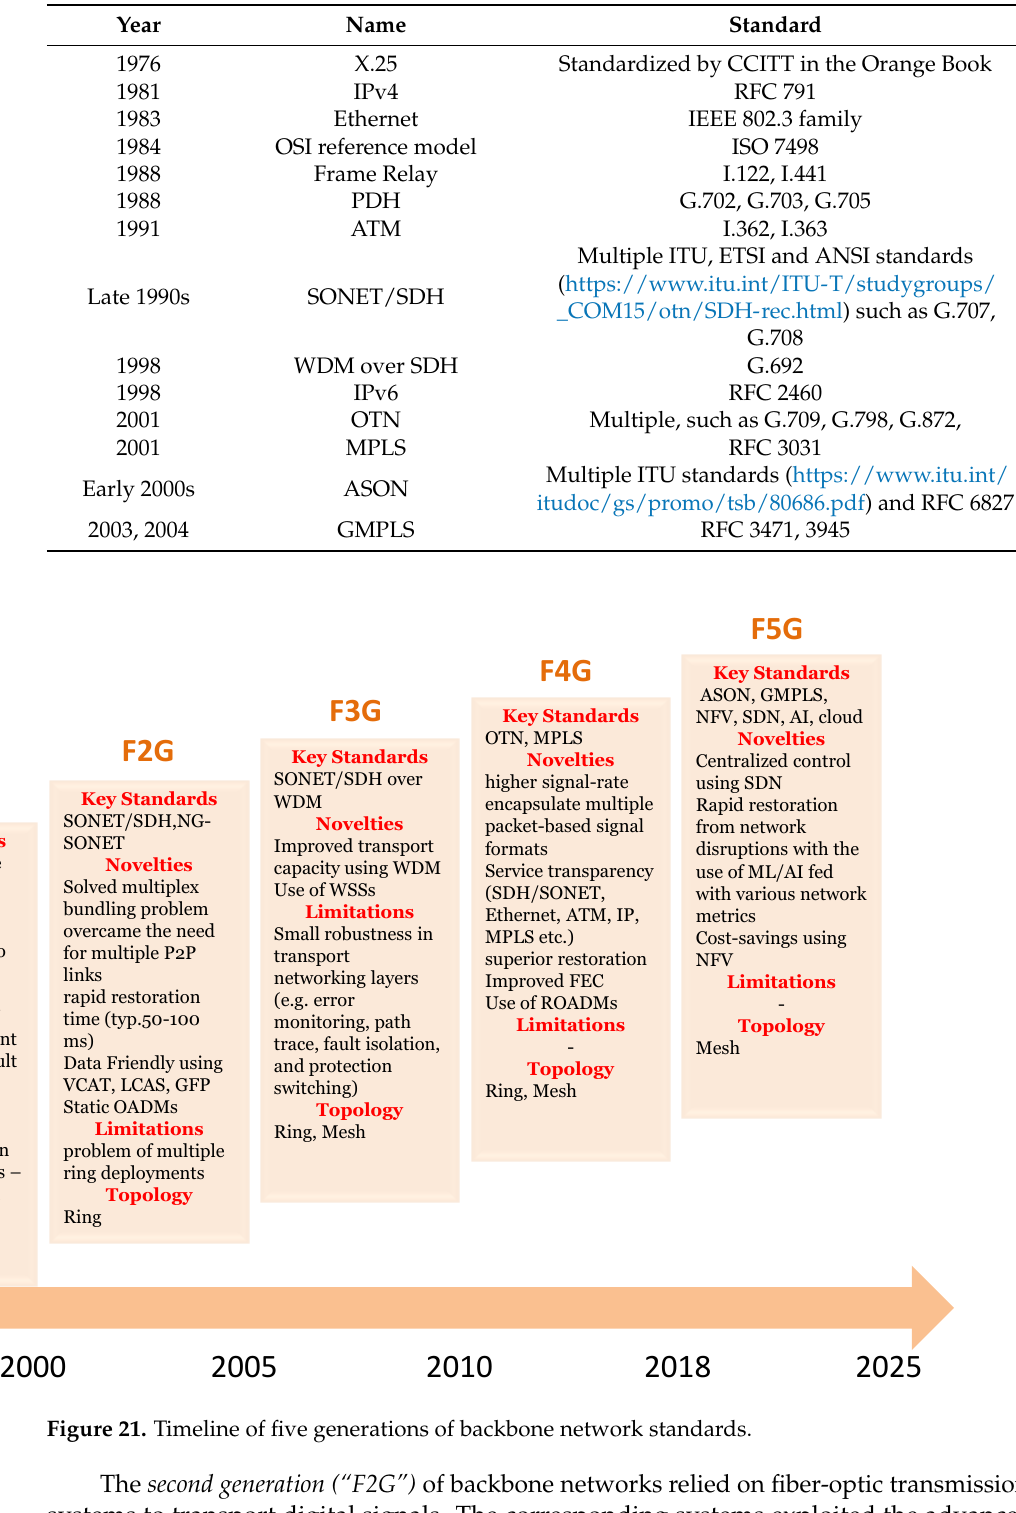
Table 8. Timeline of backbone protocols and standards.